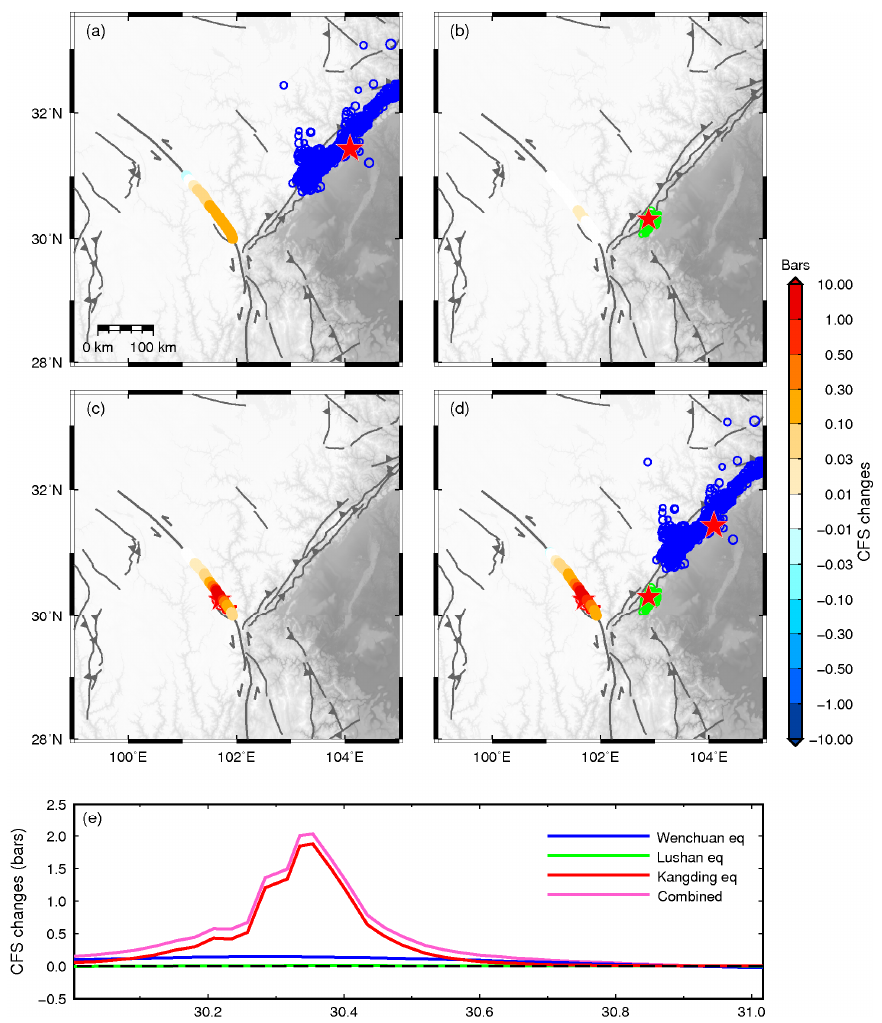
Figure 8. Coulomb failure stress (CFS) changes on the SDK caused by strong earthquakes (co ‐ and post ‐ seismic viscoelastic relaxation effects) prior to 2018 (red stars indicate earthquake epicenters). ( a ) The 2008 M w 7.9 Wenchuan earthquake. Blue circles represent aftershocks; ( b ) The 2013 M w 6.6 Lushan earthquake. Green circles represent aftershocks; ( c ) The 2014 M w 6.2 Kangding earthquake. Red circles represent aftershocks; ( d ) Combined effects of the Wenchuan, Lushan, and Kangding earthquakes; ( e ) Stress accumulation caused by strong earthquakes prior to 2018 along the SDK.